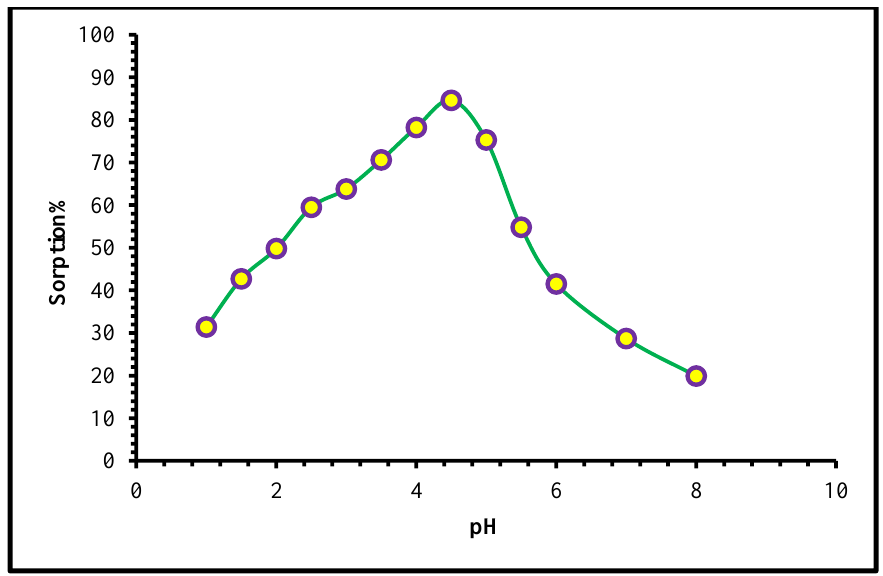
Figure 7. Effect of the solution pH on the adsorption % of W(VI) using HNAP/QA (W(VI) = 250 mg L − 1 , 20 mL solution, 30 min, room temperature).